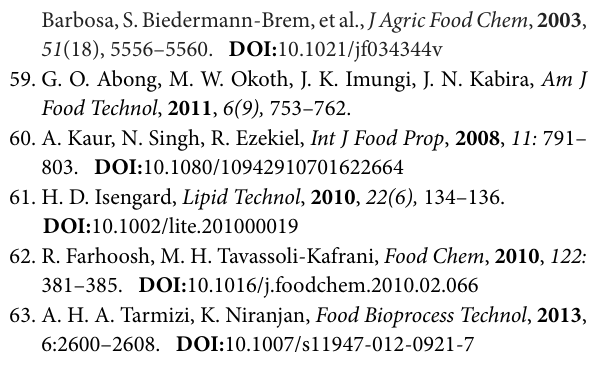
Testirali smo različne pogoje vakuumskega cvrtja pomfrita in preverjali njegove fizikalne, kemijske in organoleptične lastnosti glede na uporabljeno olje ter trajanje in temperaturo cvrtja. Da bi določil optimalne pogoje cvrtja smo pri študiji uporabili načrt s centralno zasnovo z rotacijo. Optimalni pogoji so vključevali minimalno vsebnost olja, trdoto v območ- ju 30–45 N, minimalno vsebnost akrilamida in celovito ustreznost. Optimalne rezultate cvrtja pomfrita smo dosegli s temperaturo 124.39 °C in trajanjem 8.36 min. Tako pripravljen pomfrit je ohranil željeno bravo, teksturne lastnosti in okus, vseboval pa je tudi malo olja in znižano tvorbo akrilamidov. Poleg tega se je pri vakuumskem cvrtju tudi ohranila kvaliteta